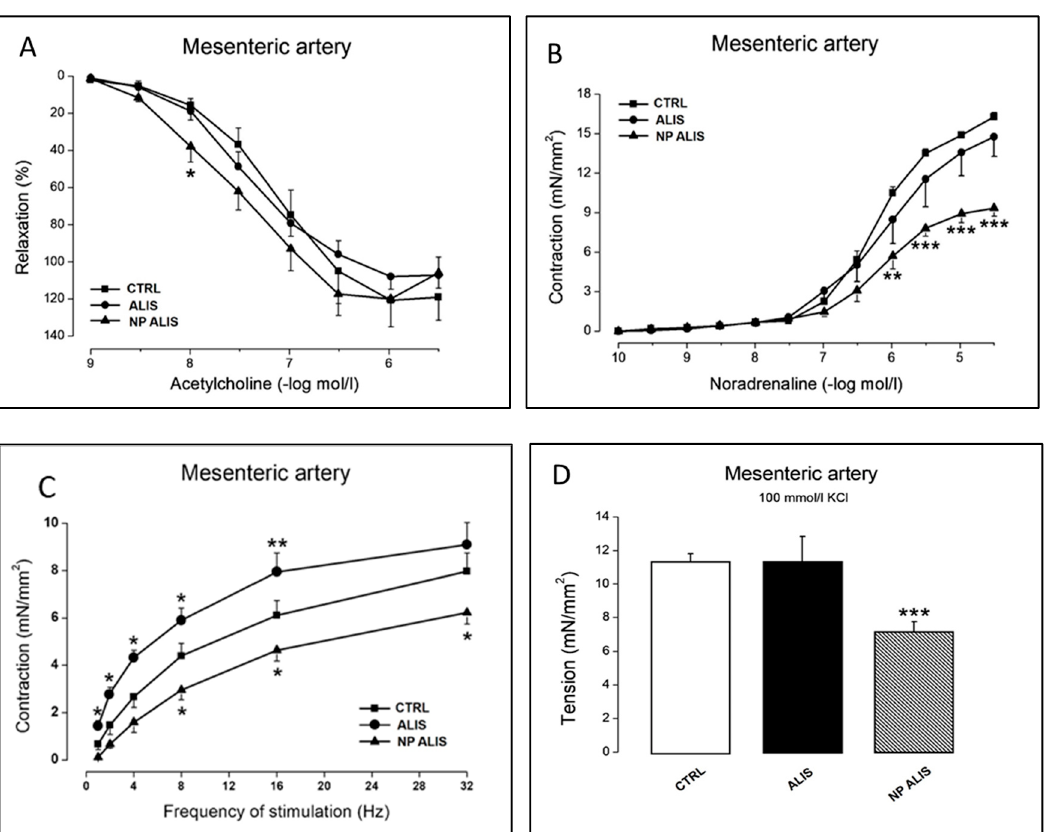
Figure 5. Effect of powdered aliskiren (ALIS) and nanoparticle-loaded aliskiren (NP ALIS) on vasoactivity of mesenteric artery. Endothelium-dependent relaxations ( a ), contractions induced by exogenous noradrenaline ( b ), neurogenic contractions ( c ), and contractions induced by high concentration of KCl ( d ). Values represent mean ± SEM of 6 measurements. Significant differences: * (**) (***) p < 0.05 (0.01) (0.001) ALIS or NP ALIS vs. CTRL.